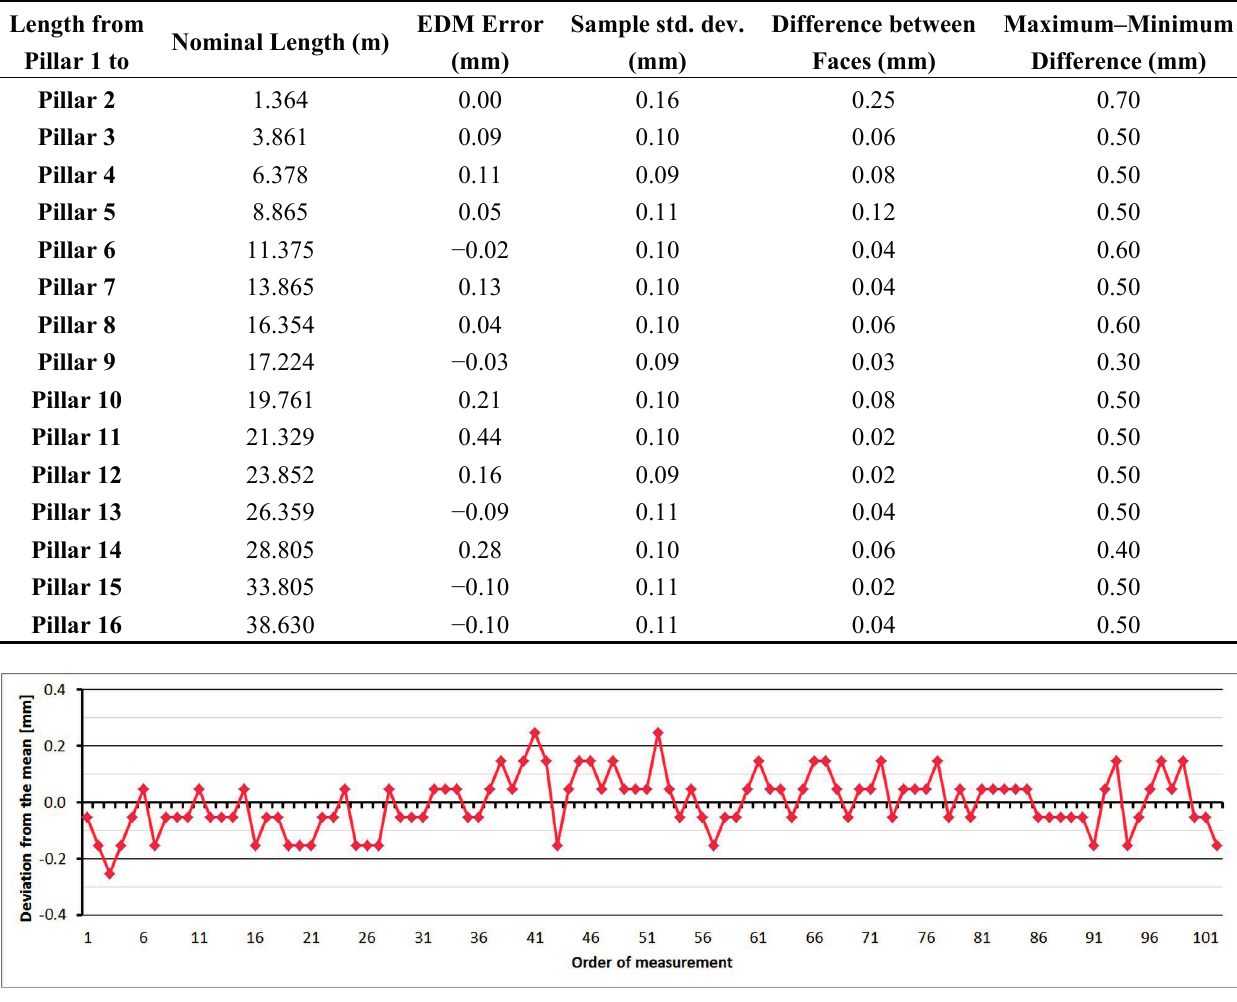
Figure 11. Leica TC1202–Differences from average distance–pillar 7 (13.9